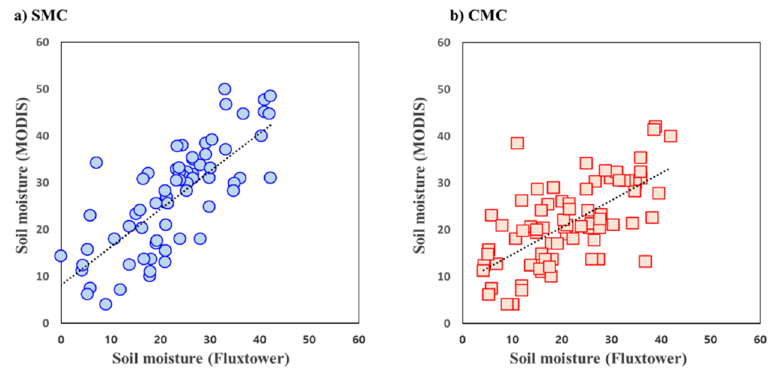
Figure 2. Temporal variations of average daily soil moisture at a ) Seolmacheon (SMC) and b ) Cheongmicheon (CMC) site.